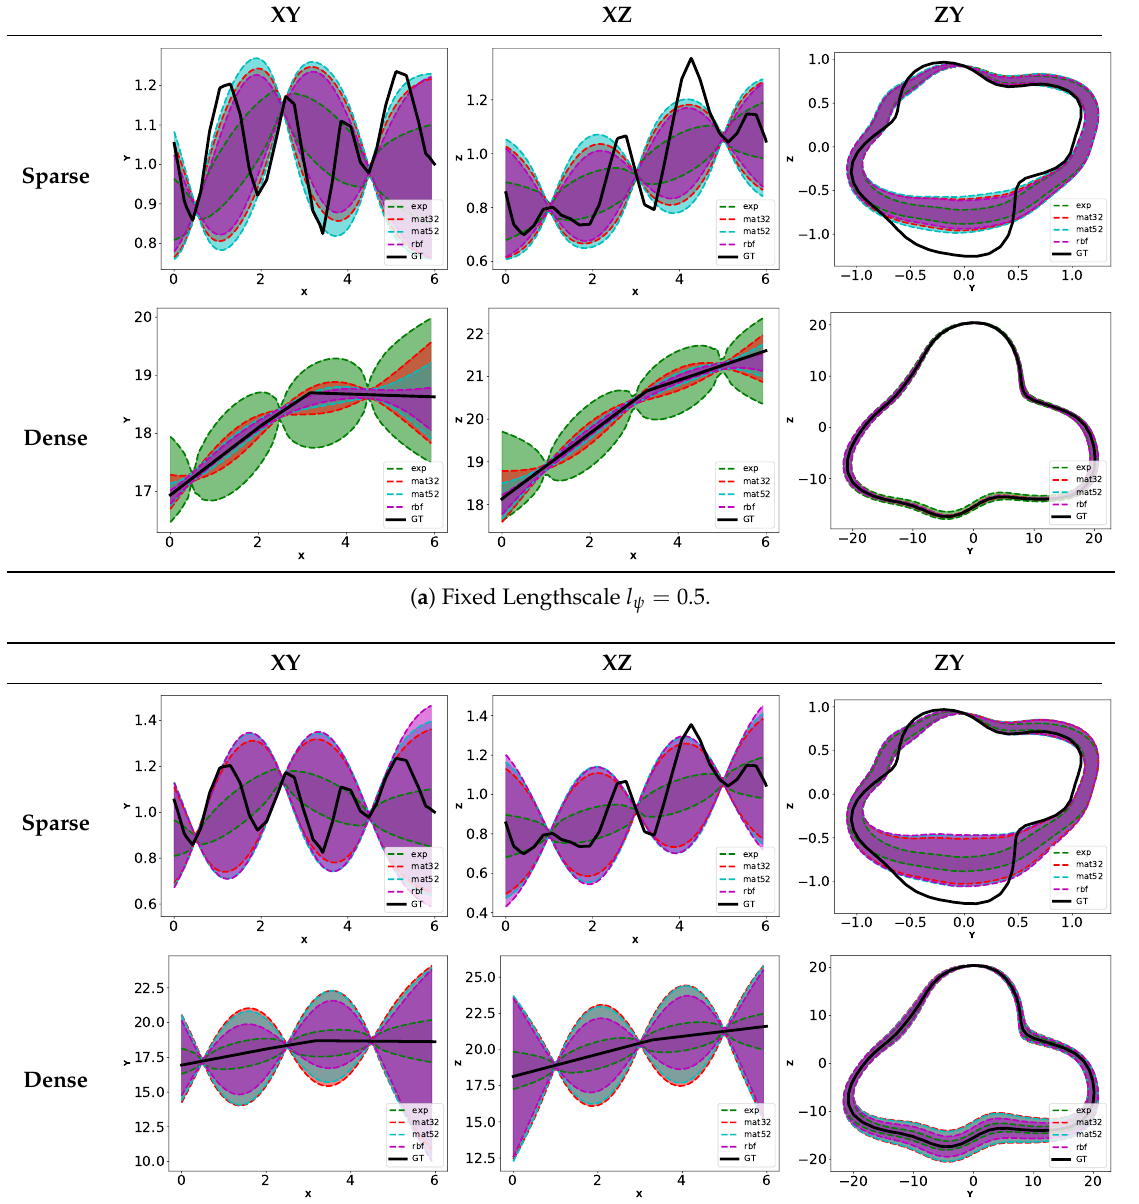
d chordal and several K s with different 5 2 ◦